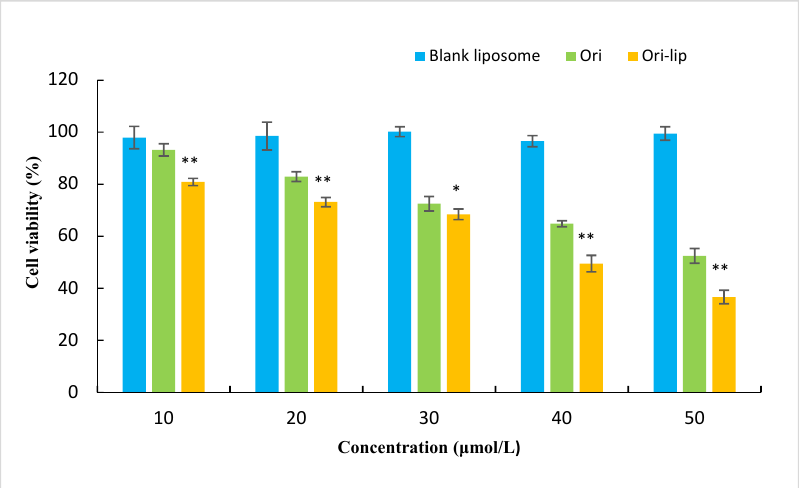
Figure 5. Cell survival curves after treating MCF-7cells with different concentrations of blank liposomes, free Ori, and Ori liposomes for 24 h. * p < 0.05, ** p <